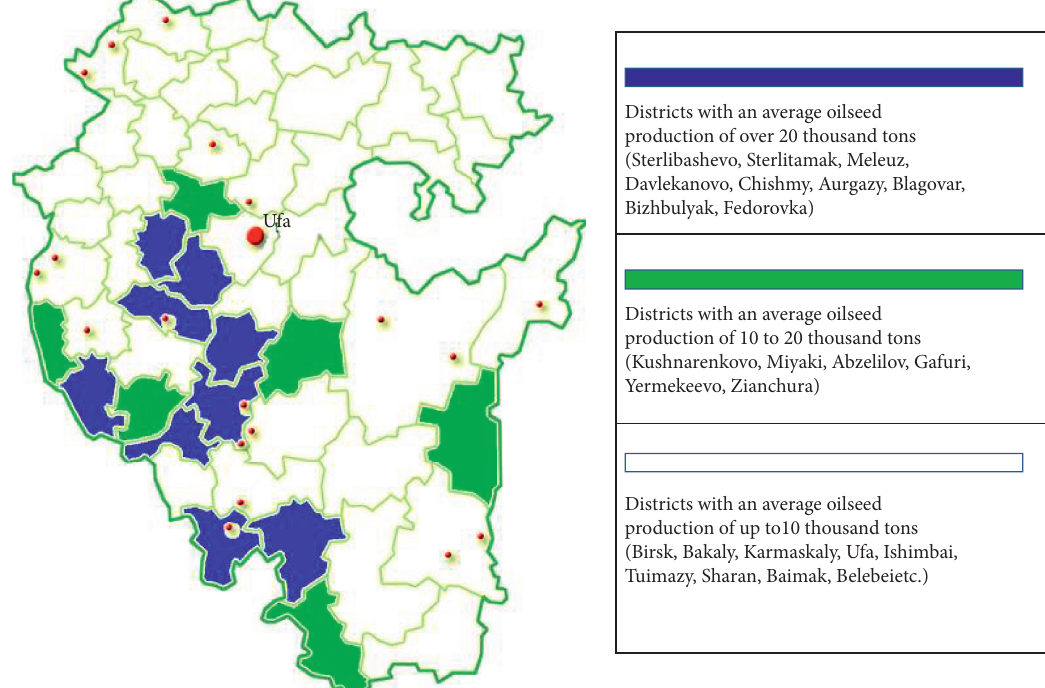
Figure 4: Territorial model of priority of participation in implementation strategic directions of the municipal regions of the republic in direction of development of oilseed production.